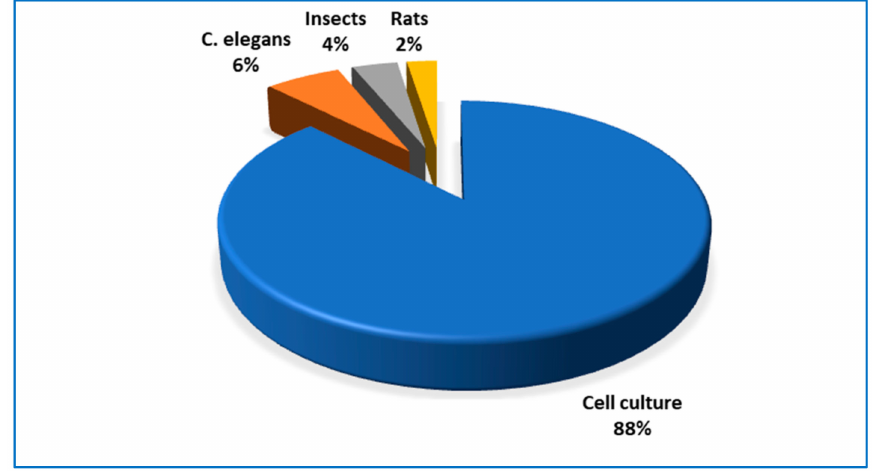
Figure 3. The percentage share of various types of experimental models applied in the reports cited in this